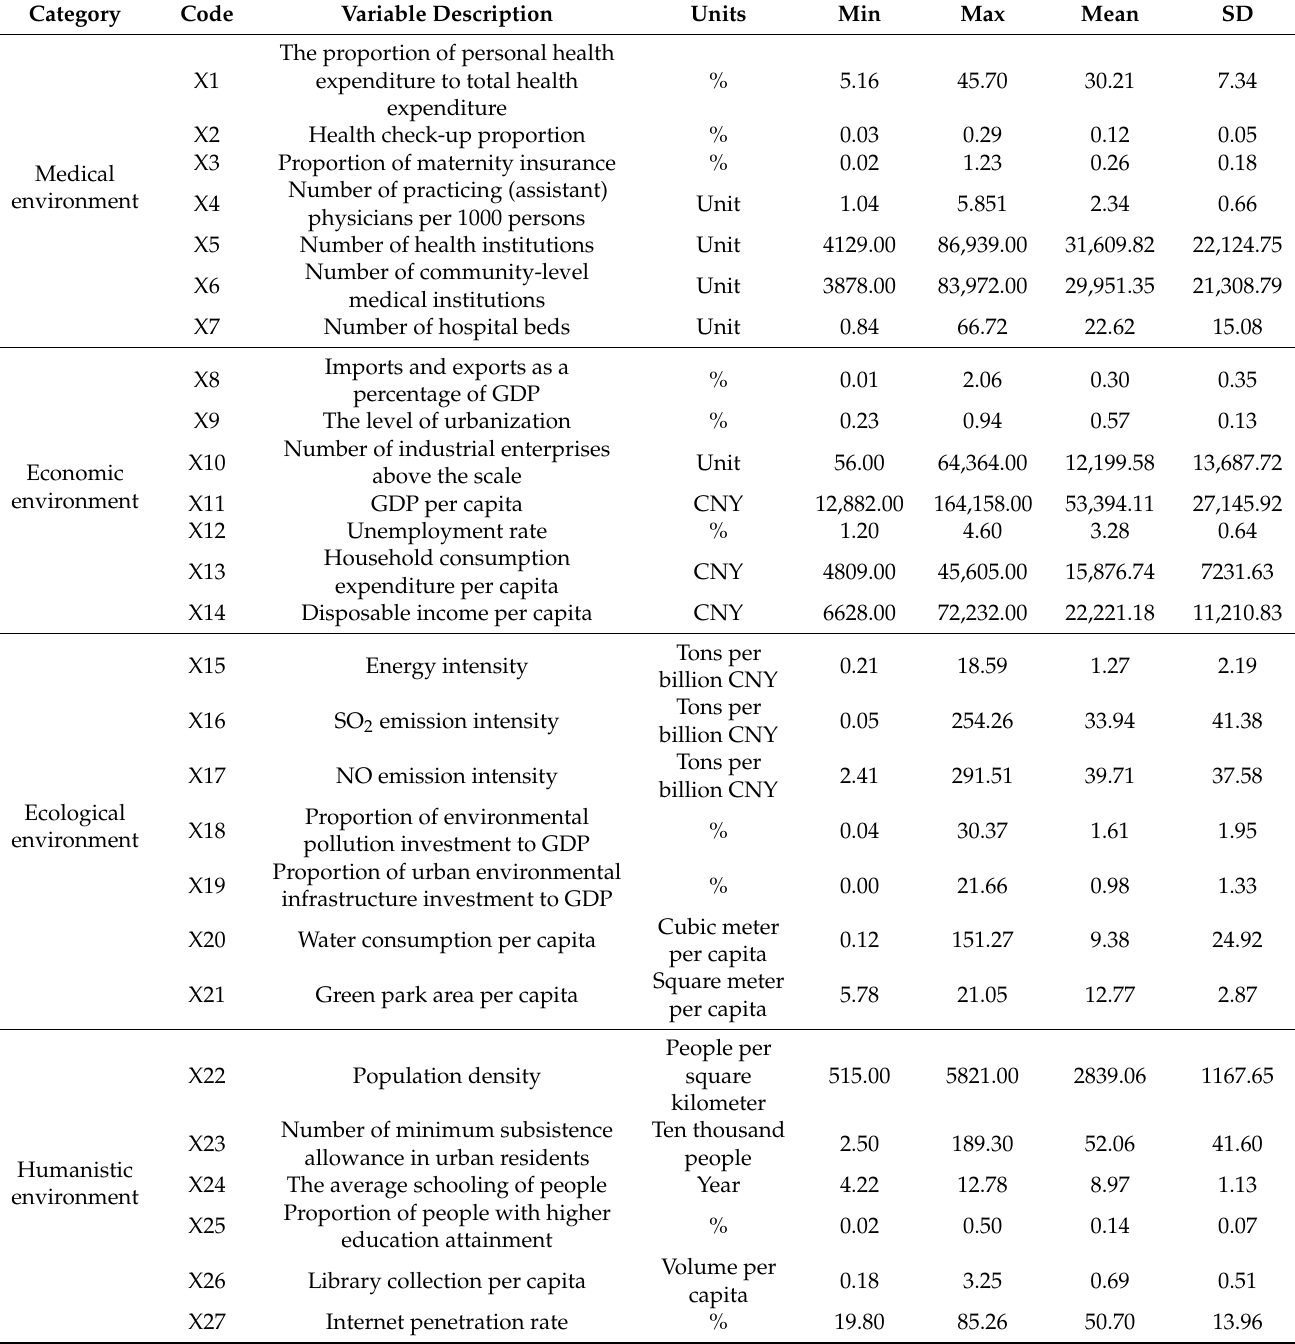
Table 1. Indicator system of healthy environment (N =